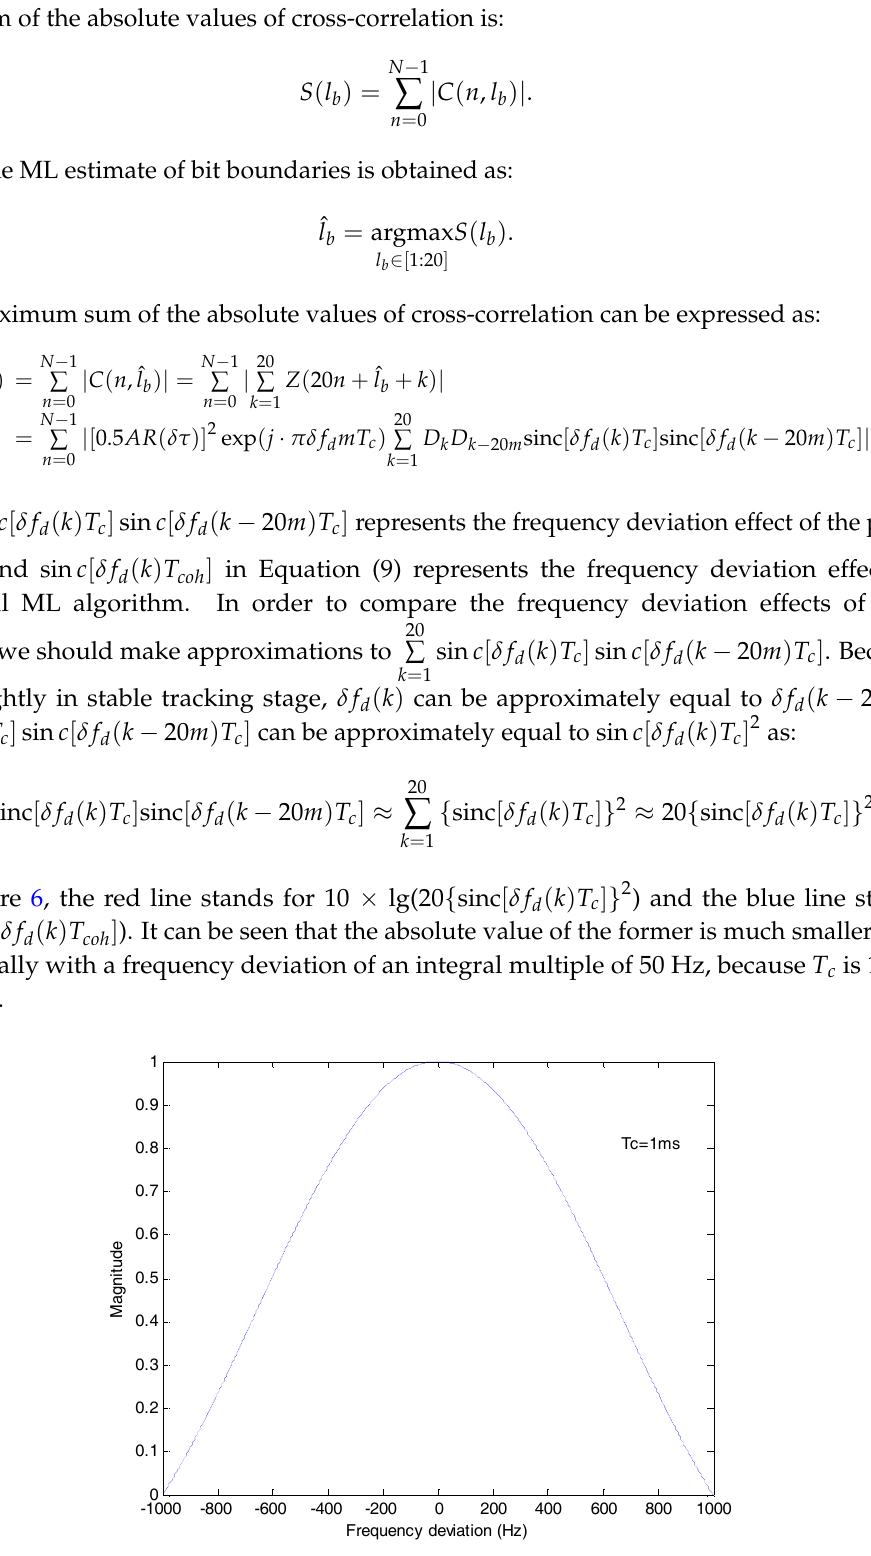
Figure 5. Data signs differential coherent algorithm with long delay time. 